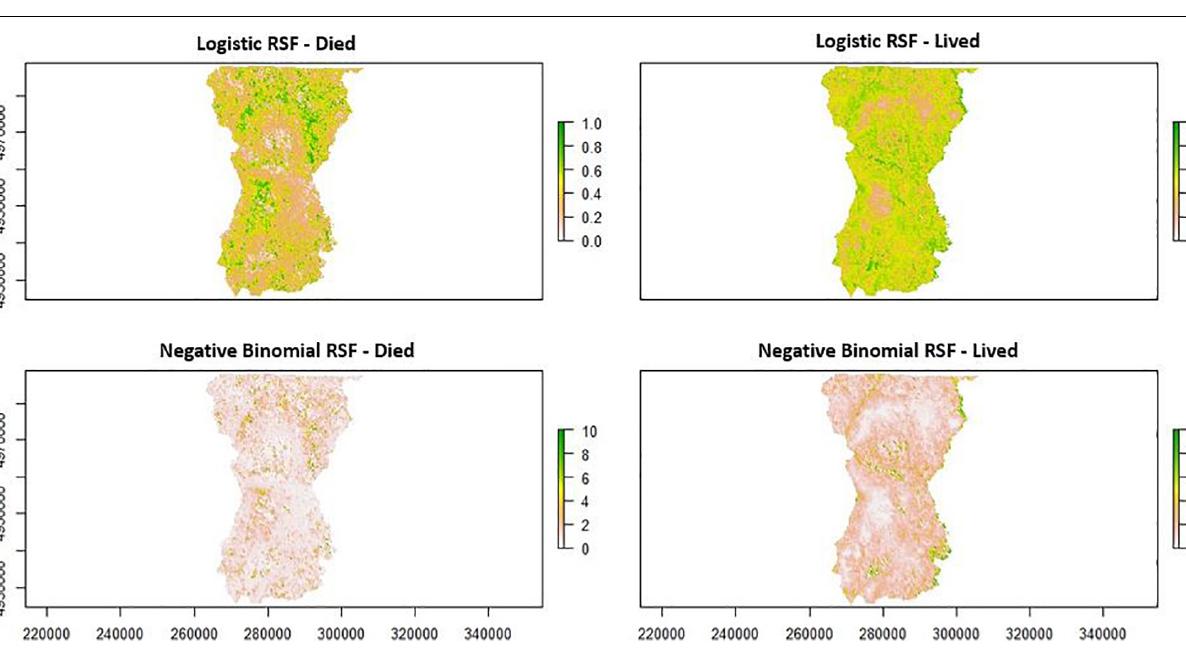
FIGURE 9 | A comparison of a logistic Resource Selection Function (RSF) and negative binomial Resource Selection Function (RSF) by female moose ( Alces alces; n = 10) during the fall winter tick ( Dermacentor albipictus ) questing period in northeastern Vermont, United States. Patches (200 m 2 ) across the study area show areas female moose selected (green color) or did not select (white) during this time period for moose whose offspring lived versus those that